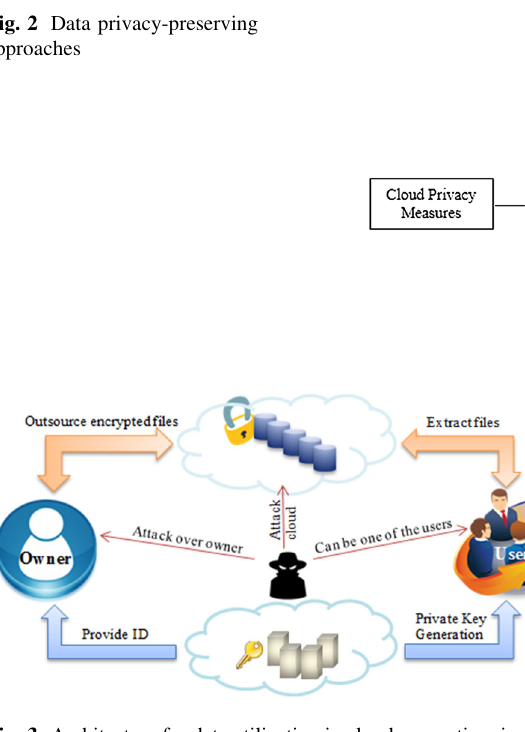
Fig. 3 Architecture for data utilization in cloud computing, including attack-prone